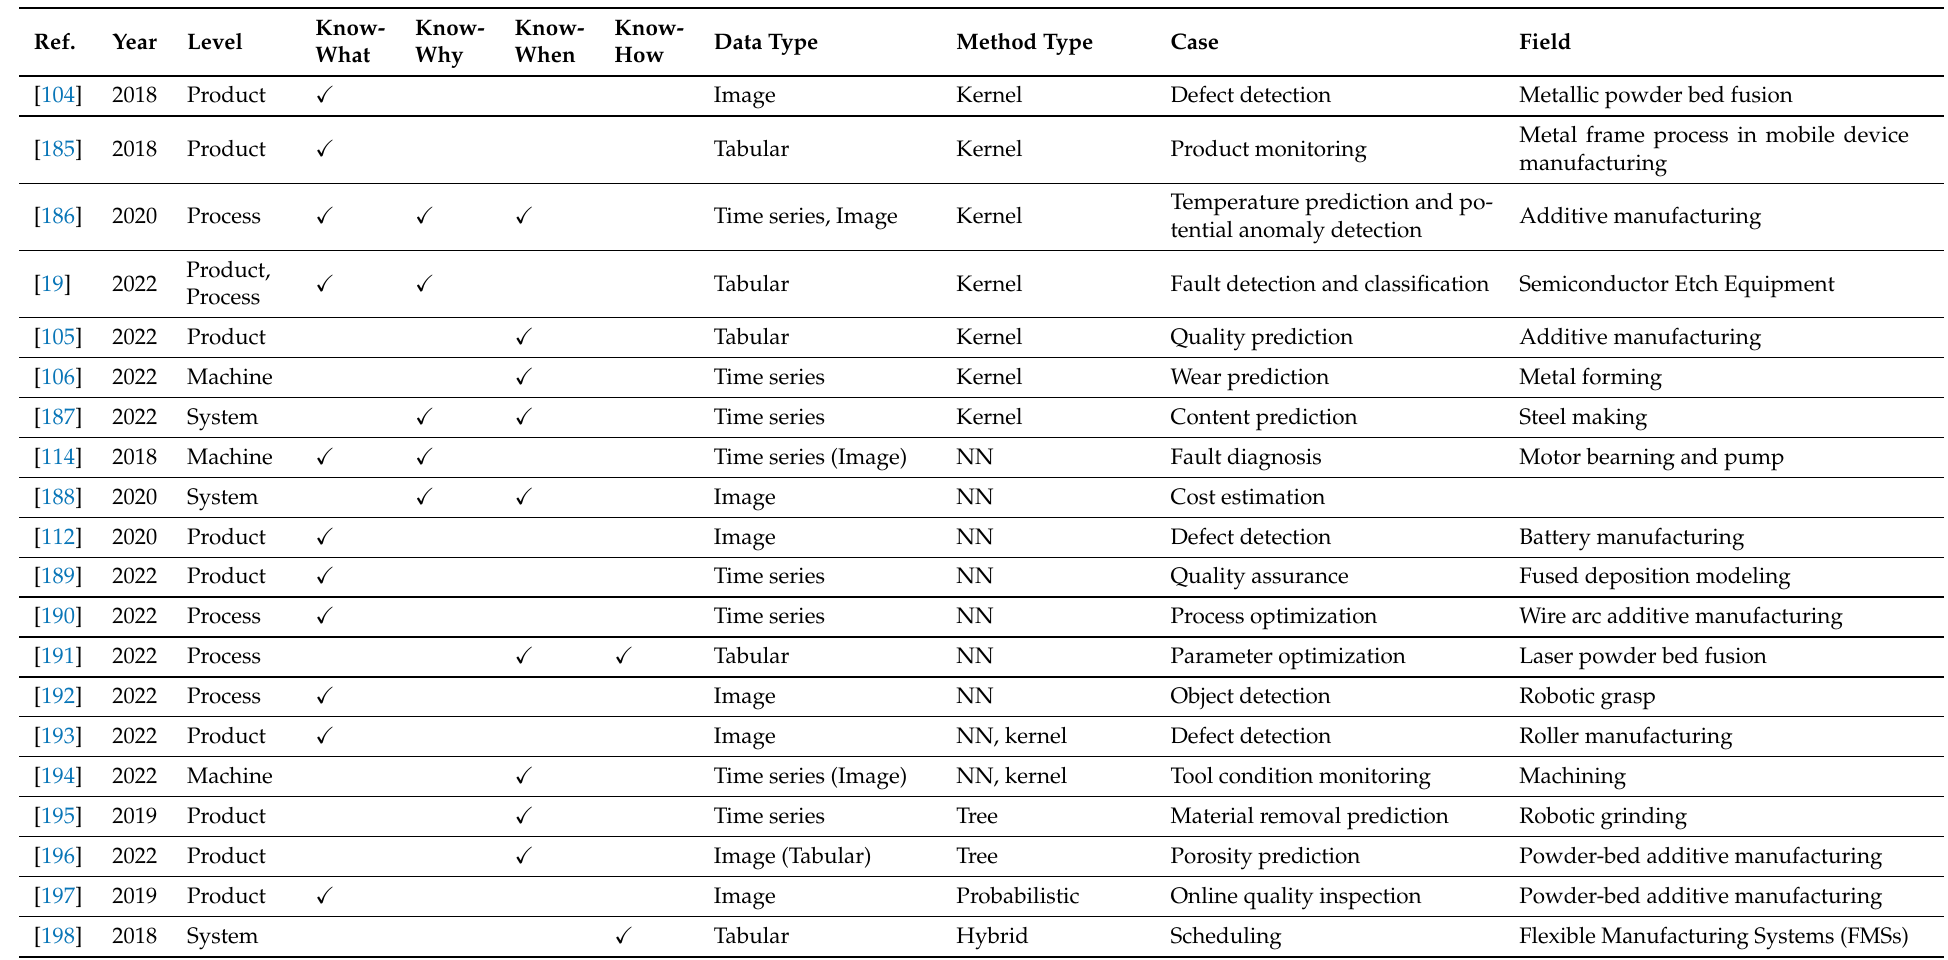
Table A1. Categories of supervised learning